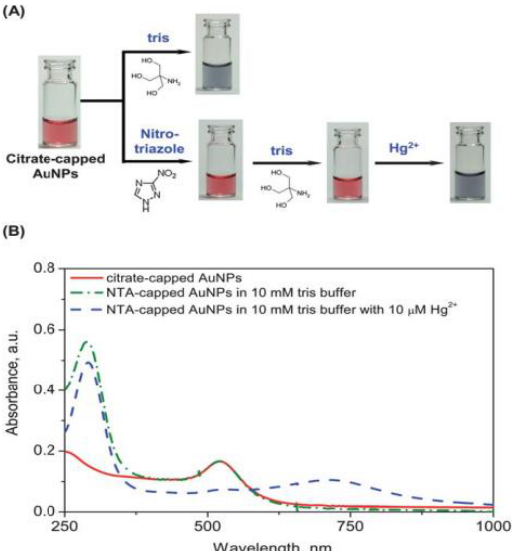
Fig. 3. (A) Color changes of the citrate capped AuNPs upon the addition of 10 mM Tris buffer, 300 mM NTA, and 10 mM Hg 2+ , respec- tively. (B) UV-vis absorption spectra of the citrate-capped AuNPs, NTA-AuNP probes in 10mMtris buffer, and NTA-AuNP probes in 10mMtris buffer with 10 mMHg 2+ , respectively. Reprinted with permission from ref. 63. Copy right 2014 Royal Society of Chemistry